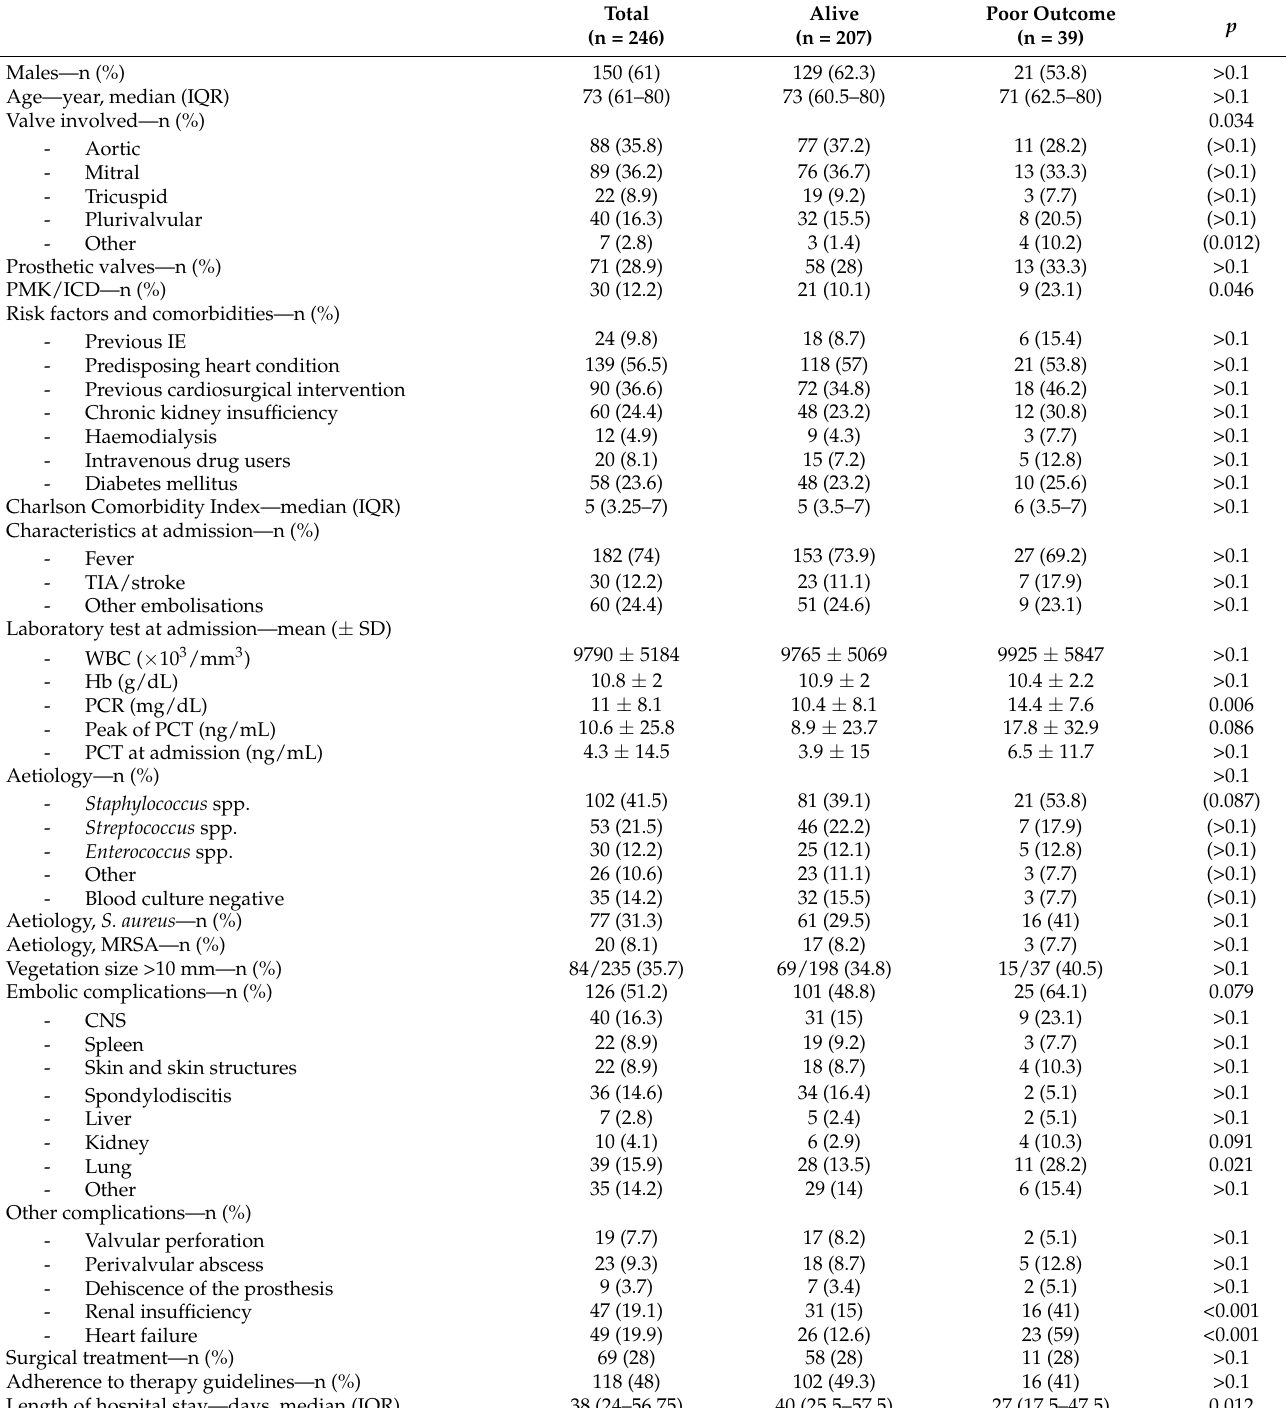
Table 2. Risk factors for in-hospital